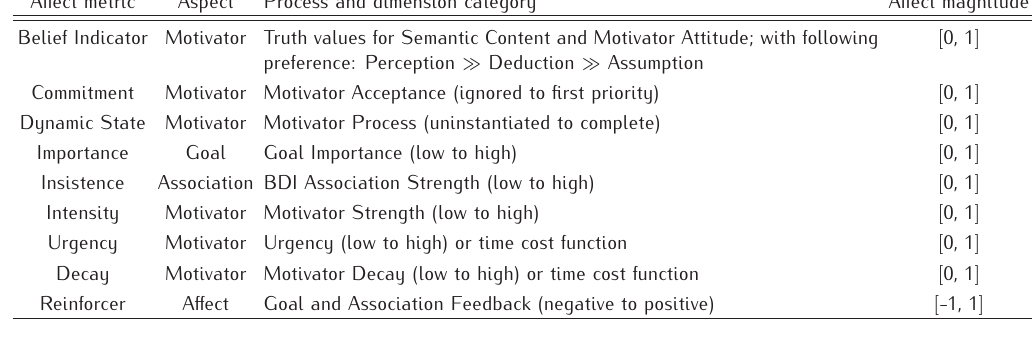
Table 1. Affect metrics used in Motivator Constructs and constituents.